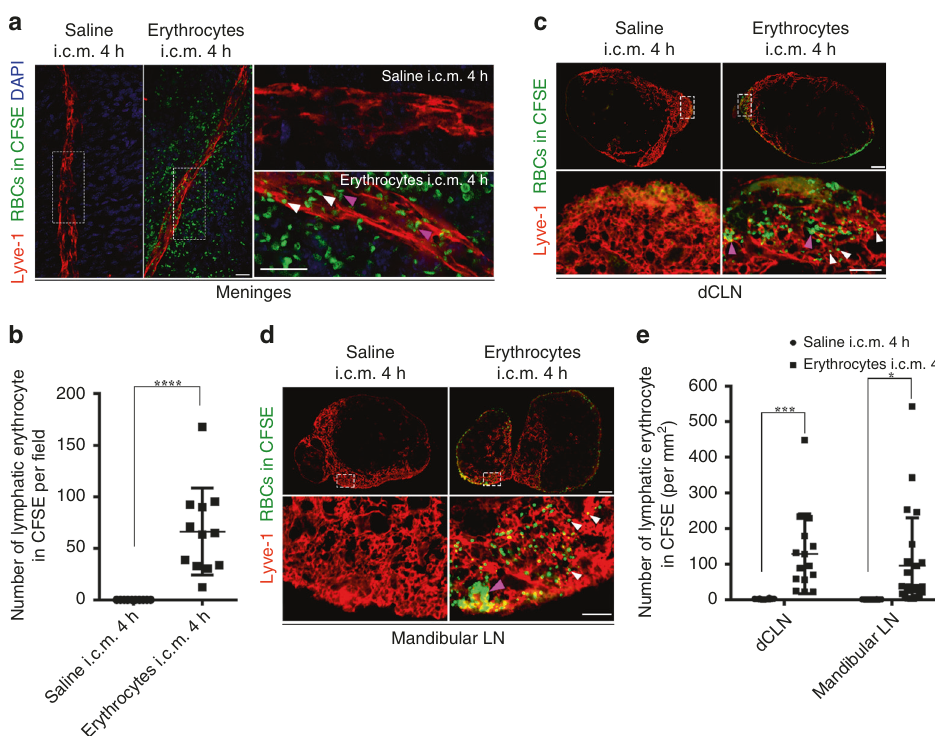
Fig. 2 Meningeal lymphatics drained erythrocytes labeled in vitro to cervical lymph nodes (CLNs). Erythrocytes (red blood cells (RBCs)) were labeled by CFSE (5-(and 6)-carboxy fl uorescein diacetate succinimidyl ester) in vitro and then injected into cistern magna. a Representative images of meningeal lymphatics draining erythrocytes in CFSE at 4 h postinjection. White arrows, morphologically intact erythrocytes. Purple arrows, degraded membrane. Regions of interest in the left images are shown on the right. Scale bar, 20 μ m (the left and right images). n = 2 independent experiments. b Quanti fi cation of the number of CFSE-labeled erythrocytes per fi eld in meningeal lymphatics on TS ( n = 12 mice per group, pooled from 2 independent experiments. P < 0.0001). c Representative images of CFSE-labeled erythrocytes in the Lyve-1-positvie lymphatic sinus of dCLNs of mice at 4 h postinjection. Regions of interest in the top images are shown below. White arrows, morphologically intact erythrocytes. Purple arrows, clusters of degraded membrane. Scale bars, 200 μ m (the top images) and 50 μ m (the bottom images). d Representative images of CFSE-labeled erythrocytes in the Lyve-1-positive lymphatic sinus of mandibular LNs of mice at 4 h postinjection. White arrows, morphologically intact erythrocytes. Regions of interest in the top images are shown below. Purple arrows, clusters of degraded membrane. Scale bars, 200 μ m (the top images) and 50 μ m (the bottom images). n = 3 independent experiments. e Quanti fi cation of the density of CFSE-labeled erythrocytes per mm 2 in Lyve-1-positive lymphatic sinus of dCLNs and mandibular LNs at 4 h postinjection (dCLN, Saline; n = 12, Erythrocytes in CFSE; n = 15 independent nodes, P = 0.0006; Mandibular LN, Saline; n = 12, Erythrocytes in CFSE; n = 23 nodes, pooled from 3 independent experiments. P = 0.0207). All data are presented as mean values ± SD; two-tailed unpaired Student ’ s t test. * P < 0.05, *** P < 0.001, **** P < 0.0001. Source data are provided as a Source data fi